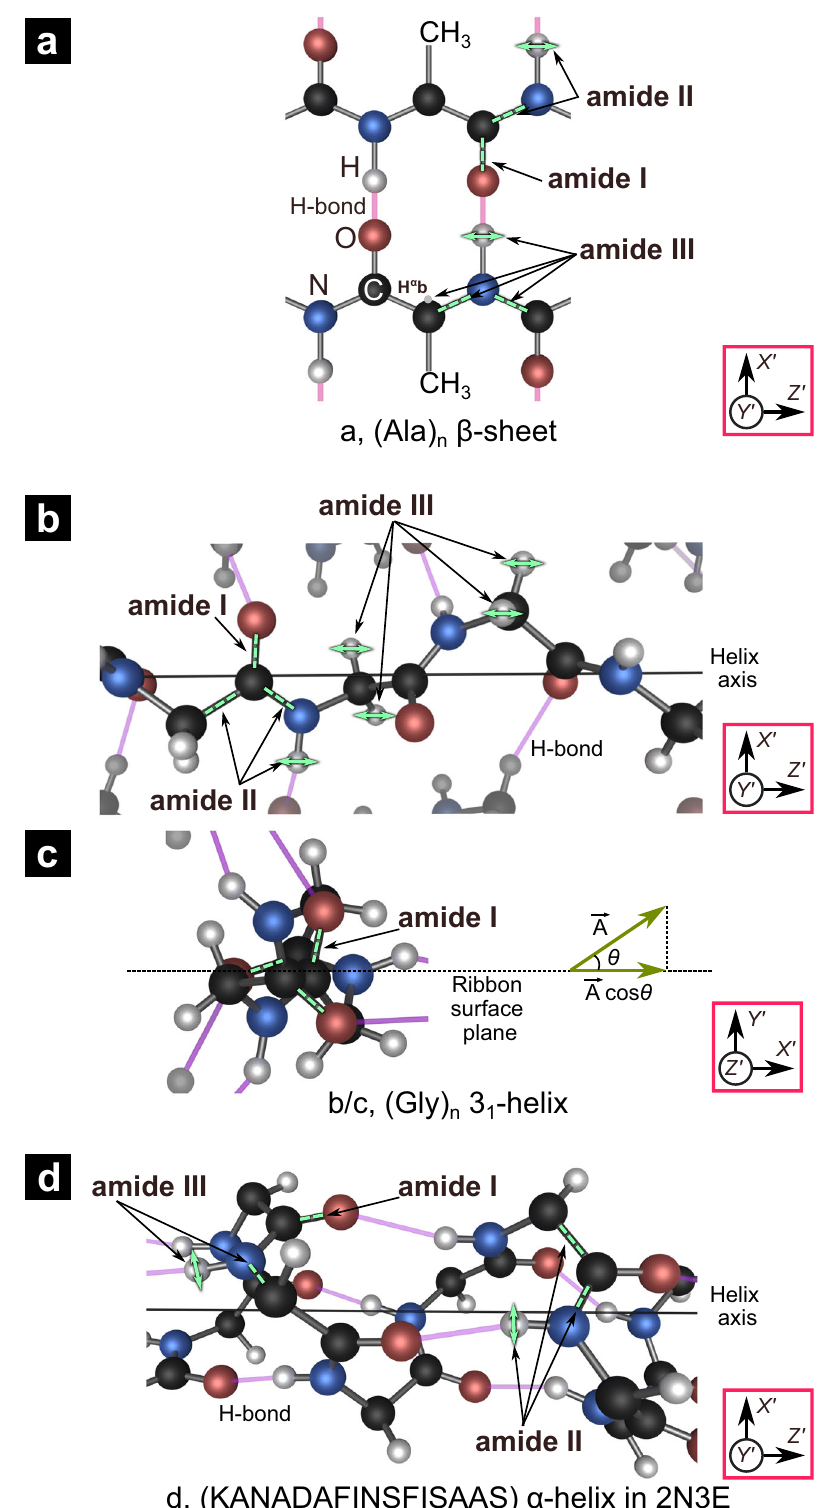
Fig. 3 Vibrations associated with amide-I/II/III bands for different secondary structures. Structure and amide-I/II/III vibrational modes in a an antiparallel β -(Ala) n β -sheet 52,58,63 . b / c a (Gly) n -II 3 1 -helix 82 . b Side view (neighboring strands dimmed; not all hydrogen bonds shown). Black solid line: helix axis. c Top view of a single 3 1 -helix (black, dashed line: recluse ribbon surface). d α -helix segment (KANADAFINSFISAAS) in the protein 2N3E (side view) 83 . Black, blue, red, and white spheres represent carbon (C), nitrogen (N), oxygen (O), and hydrogen (H) atoms, respectively. H-bonds are represented by light purple rods. The α -hydrogens and functional groups are not shown for β -sheet and α -helix, respectively. Amide-I/II/III modes are indicated by green dashed lines and arrows. The axes in the red boxes represent the local orthogonal